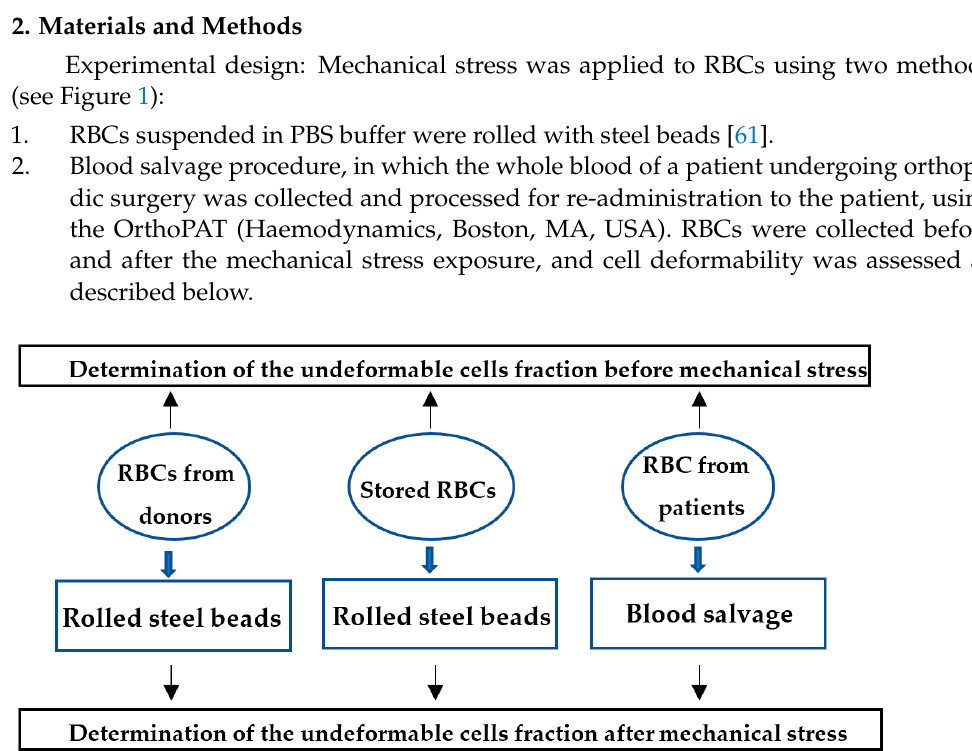
Figure 1. Flowchart of the experimental design.